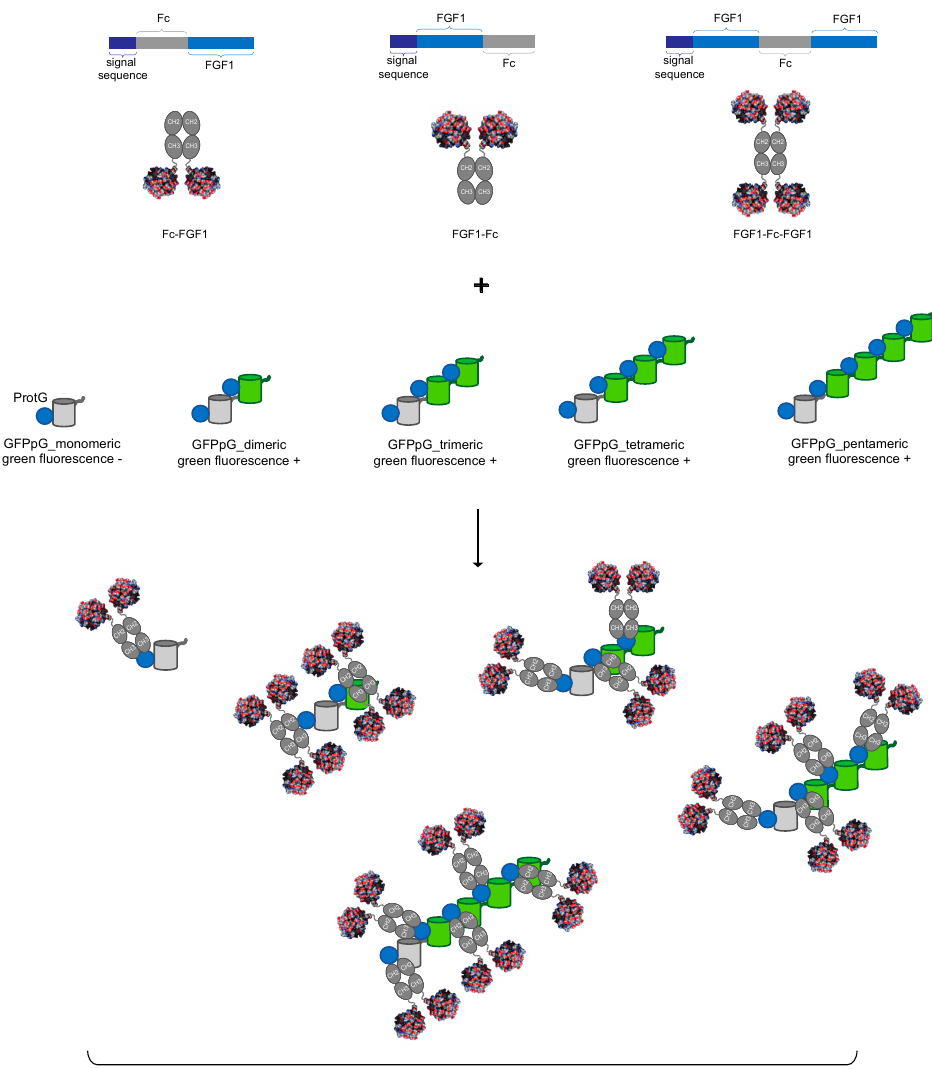
Figure 1. The strategy to generate multivalent ligand complexes consisting of bi- or tetravalent FGF1 variants and various GFPpolygonsProtG oligomers (GFPpG). In this approach, the monovalent FGF1 ligand is dimerized by N- or C-terminal fusion with the Fc fragment of human IgG1, yielding FGF1-Fc and Fc-FGF1. For development of the tetravalent FGF1 (FGF1-Fc-FGF1), a monovalent ligand was fused to both termini of the Fc fragment. GFPpolygons fused with protein G (GFPpG) constitute oligomerization scaffolds and, due to their fusion with protein G, ensure efficient Fc fragment binding. Mixing Fc-fused ligands and oligomeric GFPpG proteins leads to the assembly of multivalent FGF1 complexes.